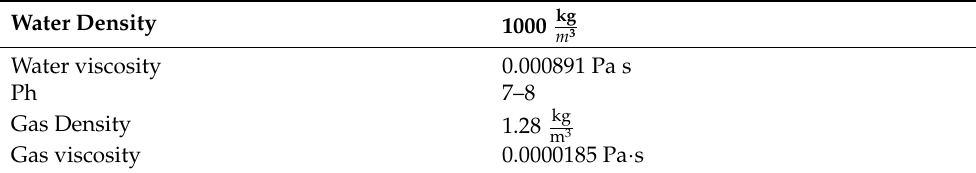
Table 1. Fluids standard properties.